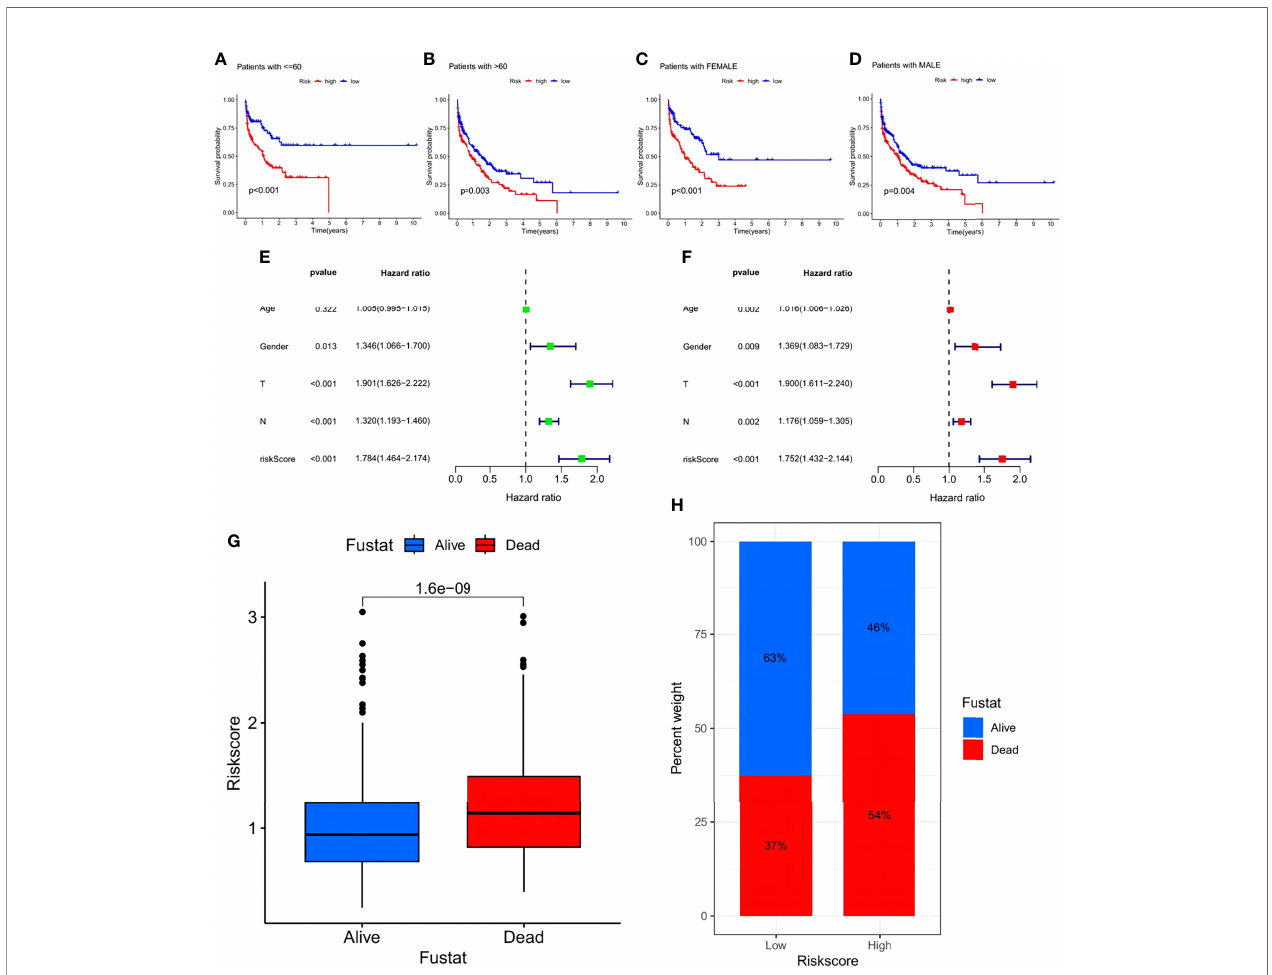
FIGURE 8 | Investigation of the prognostic potential of the risk signature. (A – D) Survival analyses conducted on patients with distinct biological background, including age and gender. (E) Univariate COX regression analysis in the merged cohort. (F) Multivariate COX regression analysis in the merged cohort. (G) Evaluation of the risk score of samples with different future status. (H) Percentage of the alive and dead samples in low- and high-risk score groups,